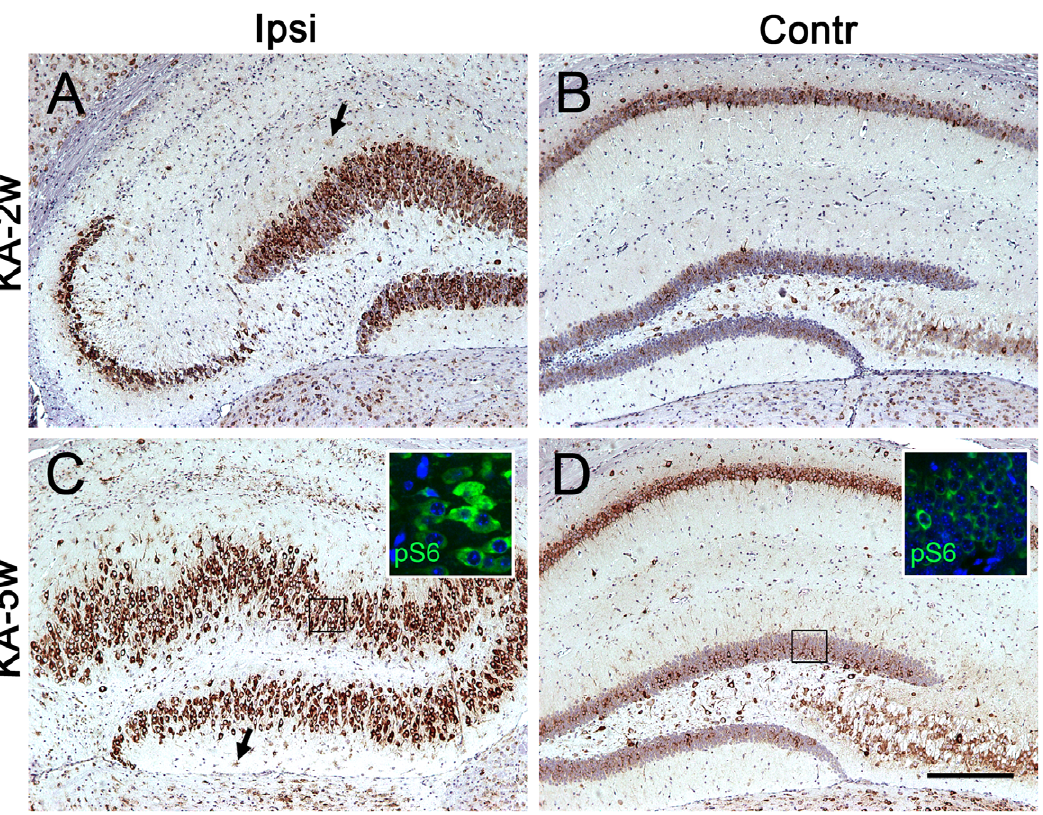
Figure 3. pS6 expression in the sclerotic hippocampus (HS) and non-sclerotic controls (non-HS). Non-sclerotic hippocampus displays weak pS6 IR in glial cells of the hilus (A), while in CA1 and CA3, staining is mainly observed in the cytoplasm of pyramidal cells, and only a few glia are pS6-positive (a-d). In the sclerotic hippocampus, a large number of astrocytes (B) with significantly increased pS6 IR are observed in dentate gyrus (DG) subfields including the hilus (B) and the molecular layer (e). Astrocytes with up-regulated pS6 invade the dispersed granular layer (C). Immunofluorescence image shows colocalization of pS6 (green) with GFAP (red) in astrocytes surrounded by neurons (Inset in C). Glial proliferation and strong pS6 IR are also detected in hilus, CA1 and CA3 of subjects with HS (f-h). (E) Quantification of astrocyte-like pS6 positive cells in CA1, CA3, hilus and DG of HS (n=13) and non-HS (n=5). Error bars are means 6 SD., *P , 0.05; **P , 0.01 is based on Student’s t-test. Scale bar in A-B: 400 m m; in C: 50 m m; in D: 20 m m. ML, molecular